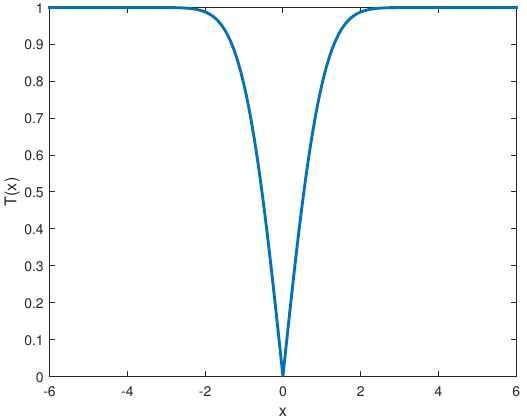
Figure 1. The V-shaped transfer